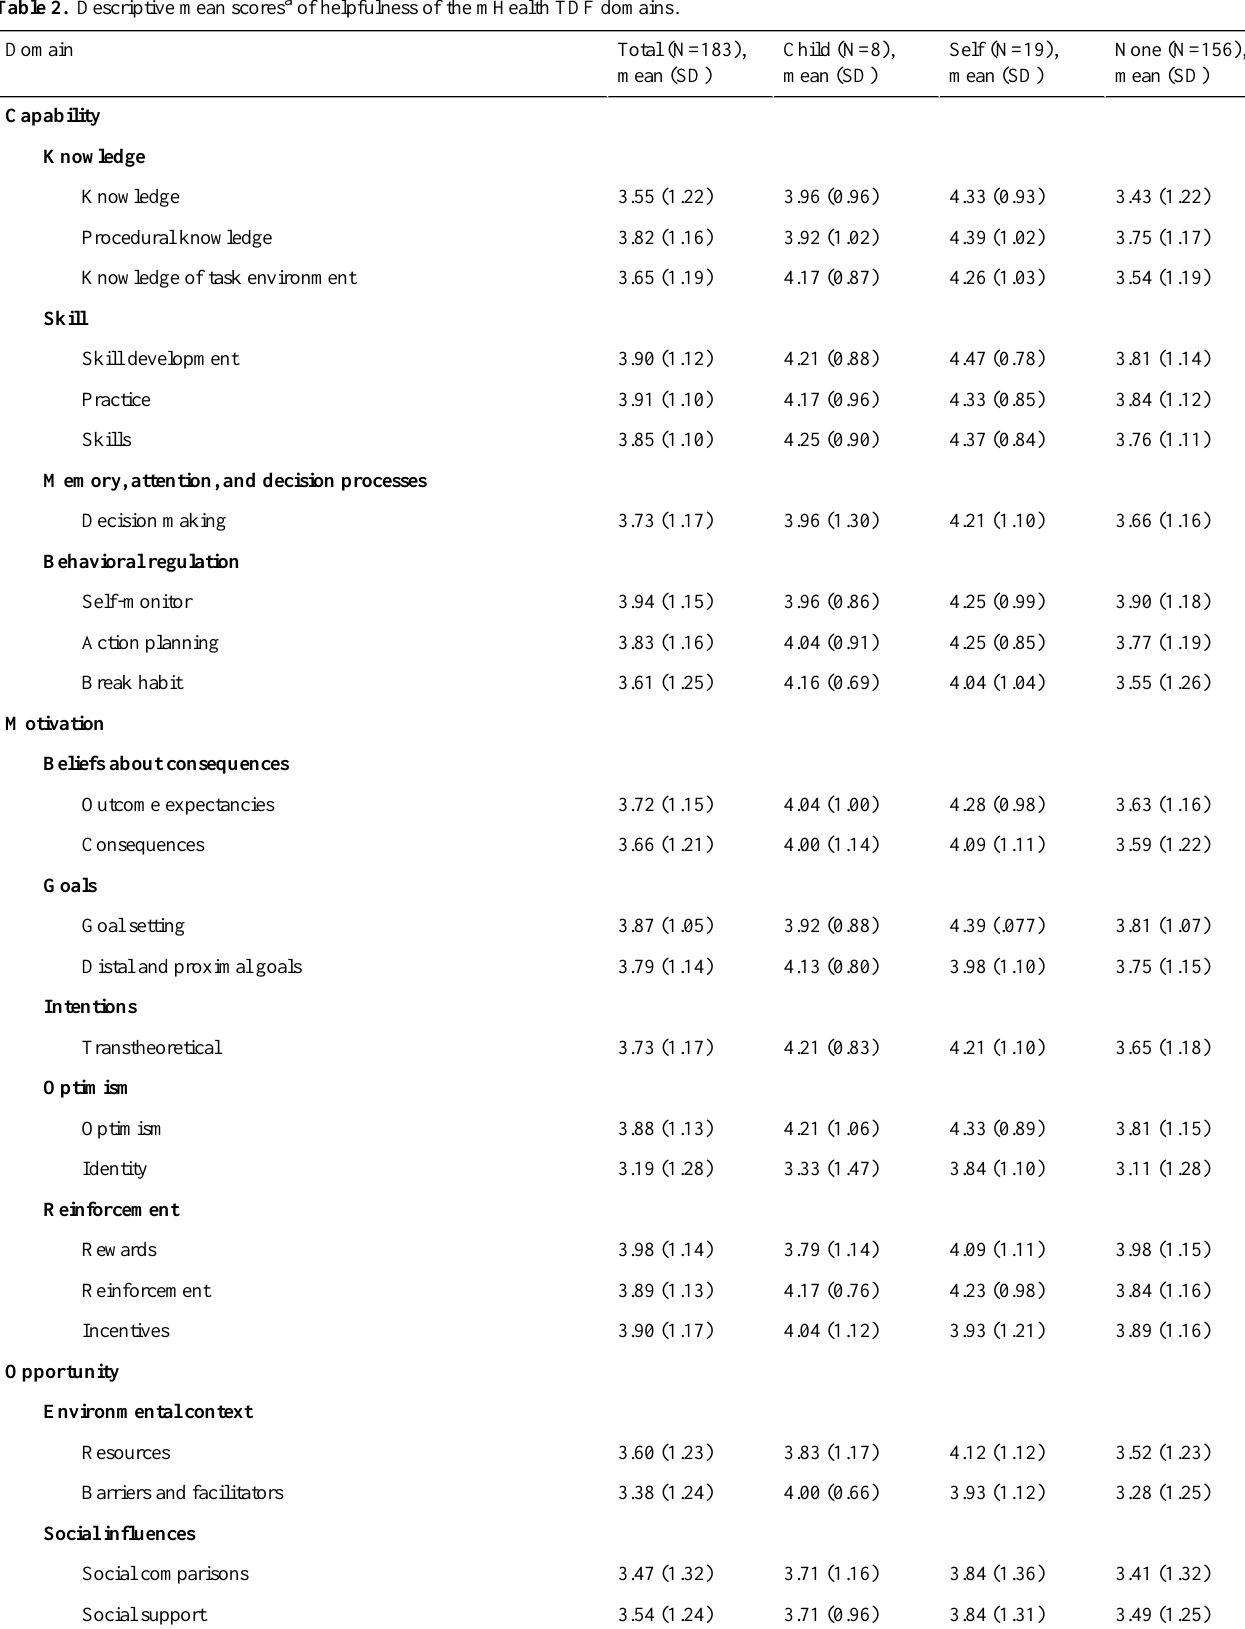
Table 2. Descriptive mean scores a of helpfulness of the mHealth TDF domains.